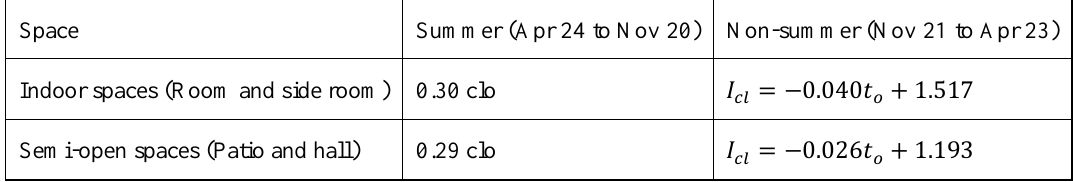
Table 4. The clothing insulation for thermal comfort calculation